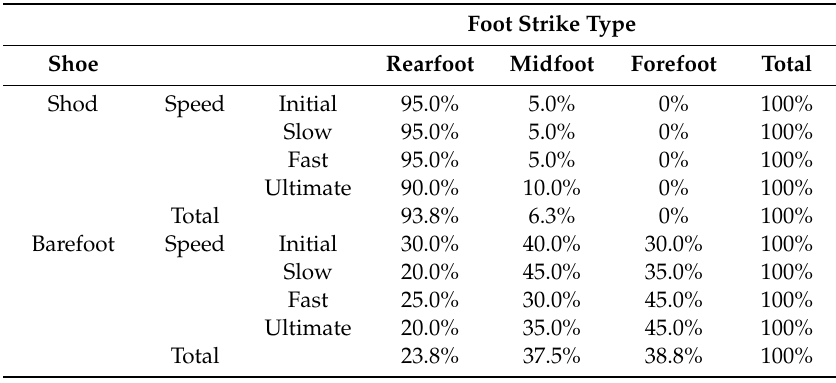
Table 1. Three-dimensional contingency table (Shoe*Speed*Foot Strikes).